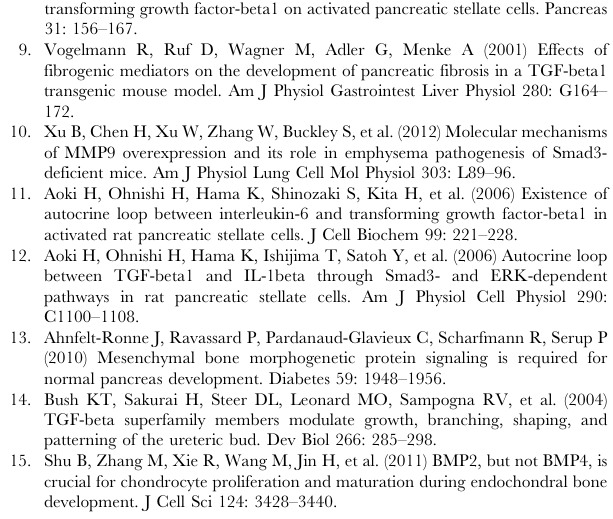
Figure S2 BMPR2 deficiency did not affect the elevated TGF- b 1 levels after CP induction. (A) Pancreatic TGF- b 1 mRNA levels were measured by qPCR. The mRNA levels